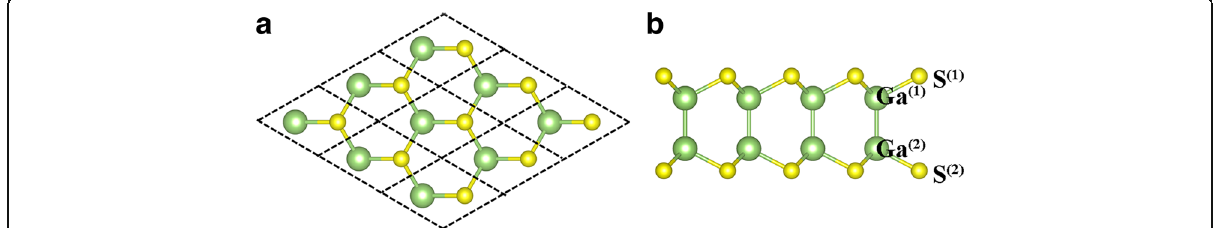
Fig. 1 a Top and b side views of the atomic configuration of GaS ML. The big green and small yellow spheres represent Ga and S atoms, respectively, and the upper and lower interlayer atoms are labeled as Y (1) (Y=Ga, S) and Y (2) ,